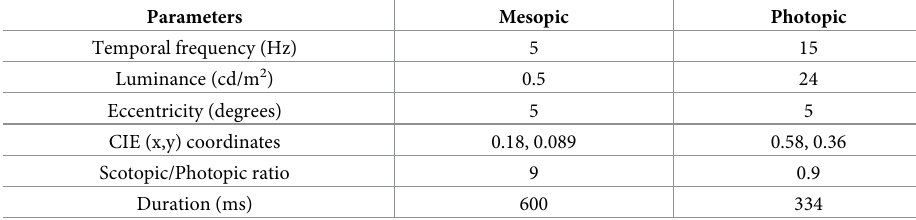
Table 1. Optimized parameters for mesopic and photopic condition used in the